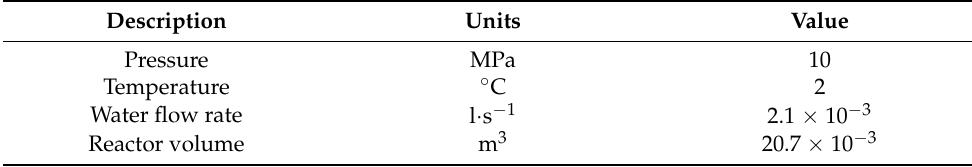
Table 2. Hydrate reactor model parameters.